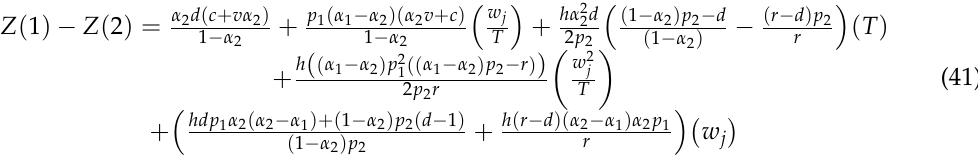
Figure 4. The rework model’s total cost versus the cycle length for each breakpoint. Bold line: permissible limits of each range, *: the answers for each range are obtained from Equation (40).